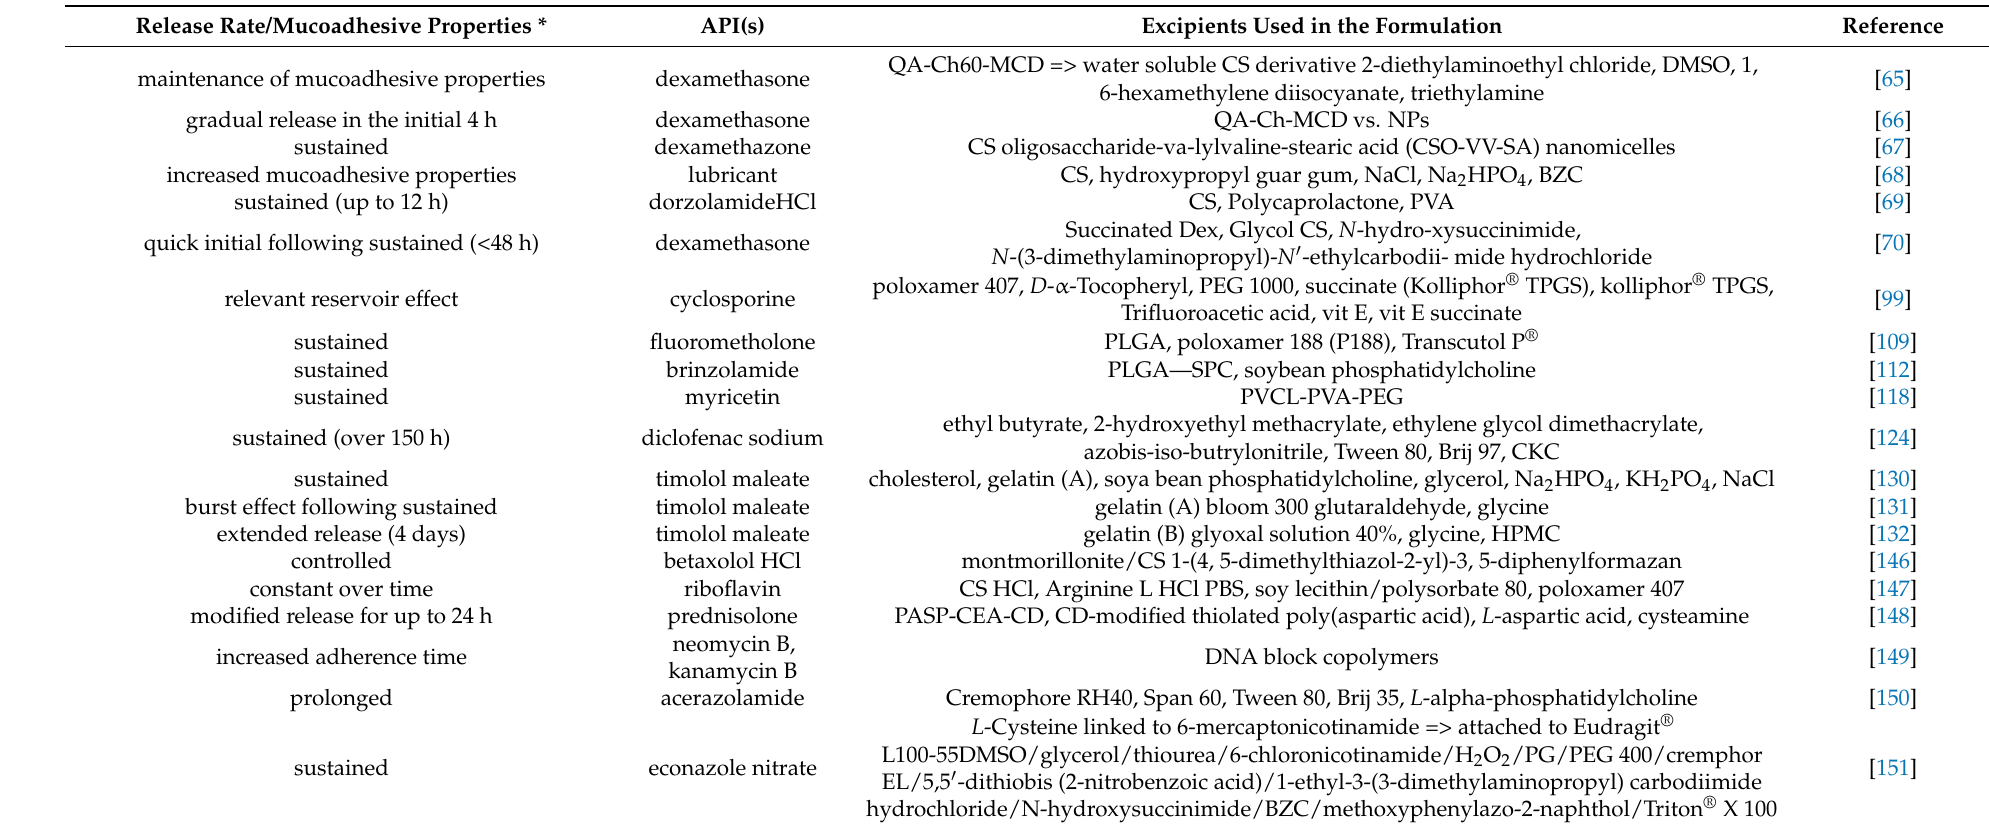
Table 1. An overview of the excipients used in modified release liquid ocular formulations (solutions, suspensions, and